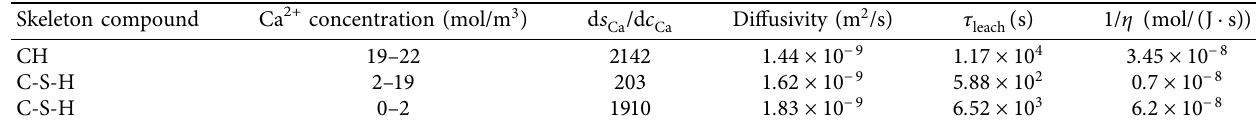
κ ( s ) d s as a function of the calcium S ∗ Ca